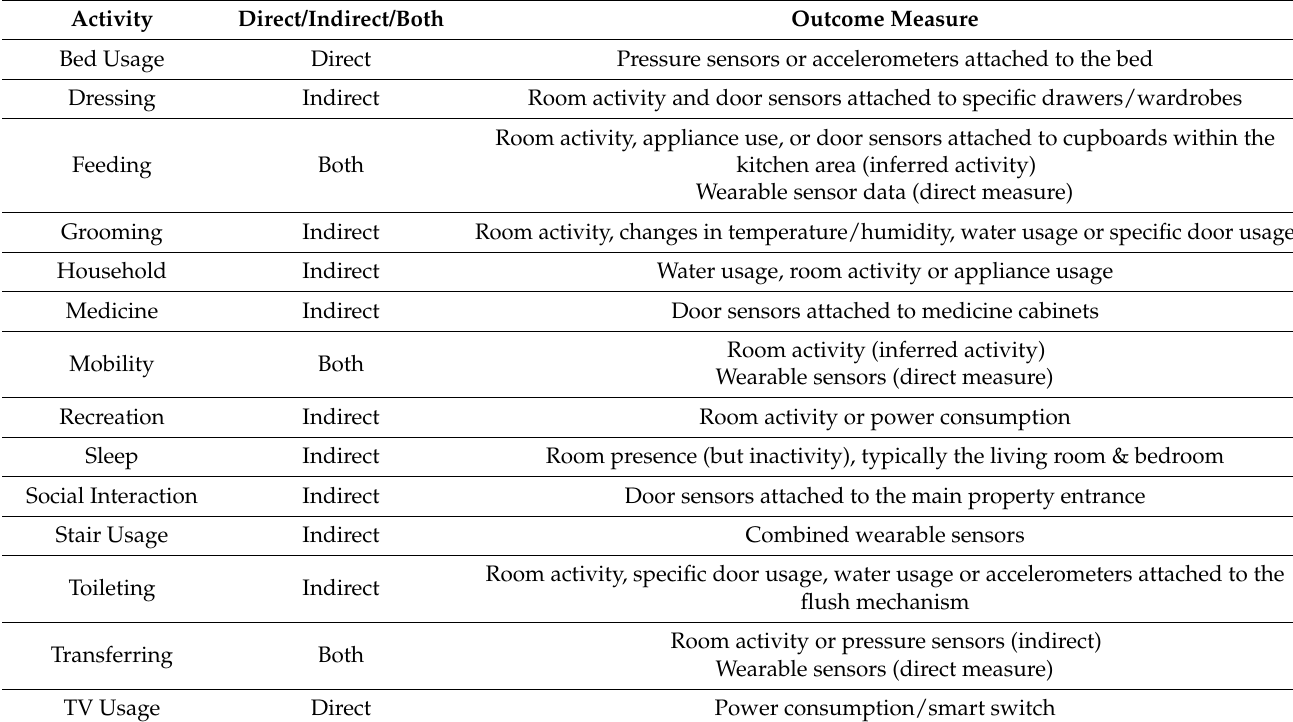
Table 5. Method used to recognise each ADL action, where direct refers to specific activities that cannot be mistaken for something else, and indirect refers to inferred recognition based on a “most likely”